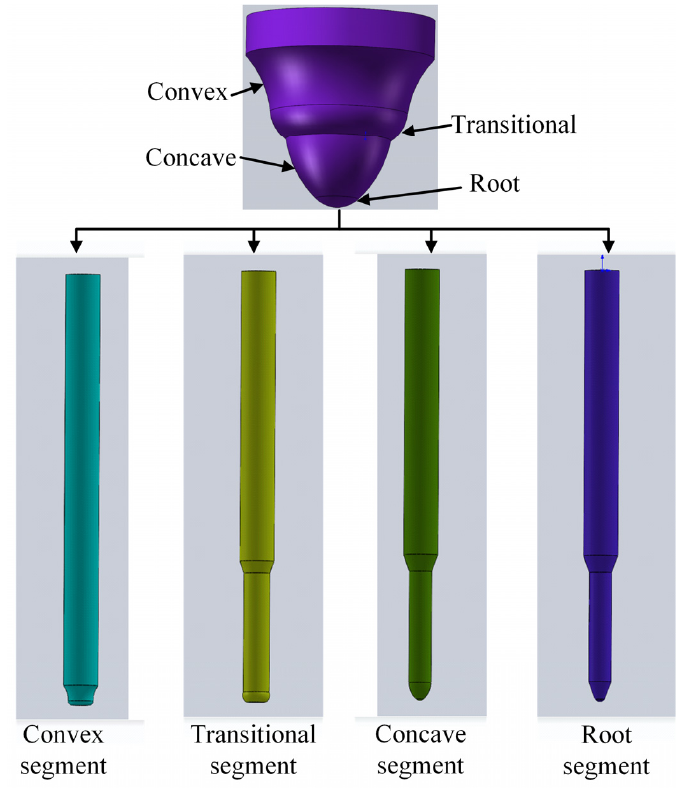
Figure 9. The resolution of the finger milling cutter.